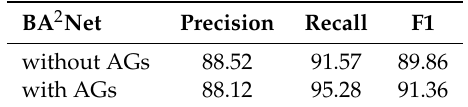
Table 2. Ablation study on attention gates of BA 2 Net.